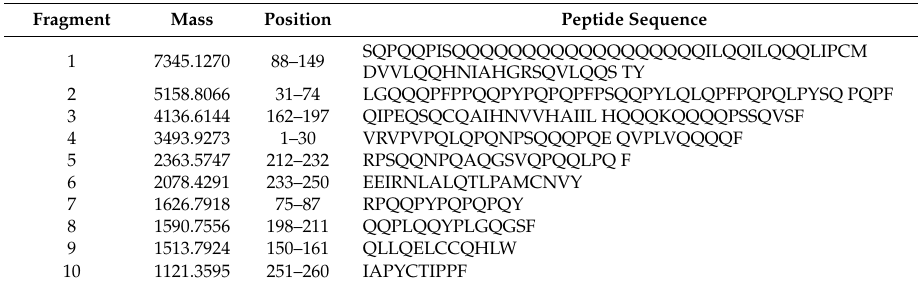
Table 1. The peptide fragments generated after α -chymotrypsin digestion of α